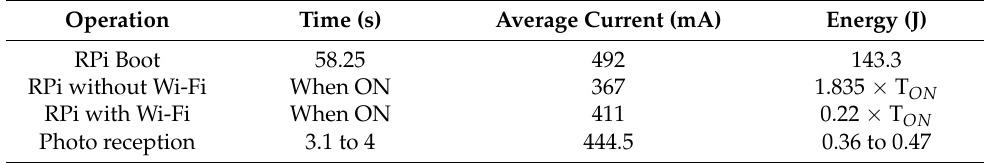
Table 7. RaspberryPi (RPi) Energy consumption.